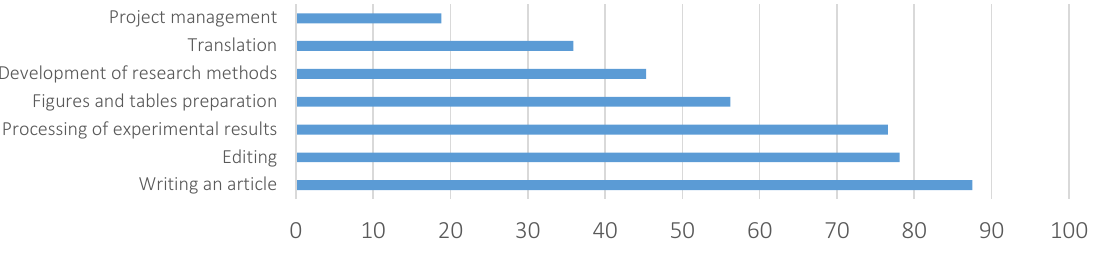
Figure 5. Roles of early career scientists as co-authors